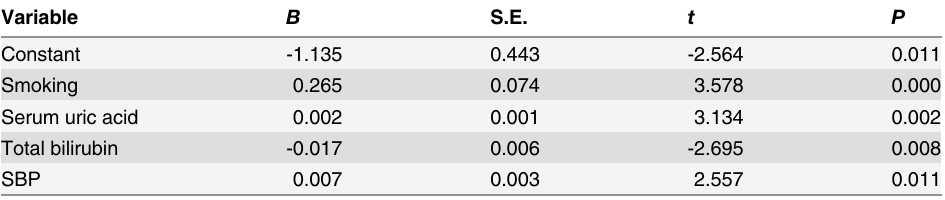
Table 3. Stepwise multiple linear regression analysis for the effect of independent variables on left ventricular mass index.